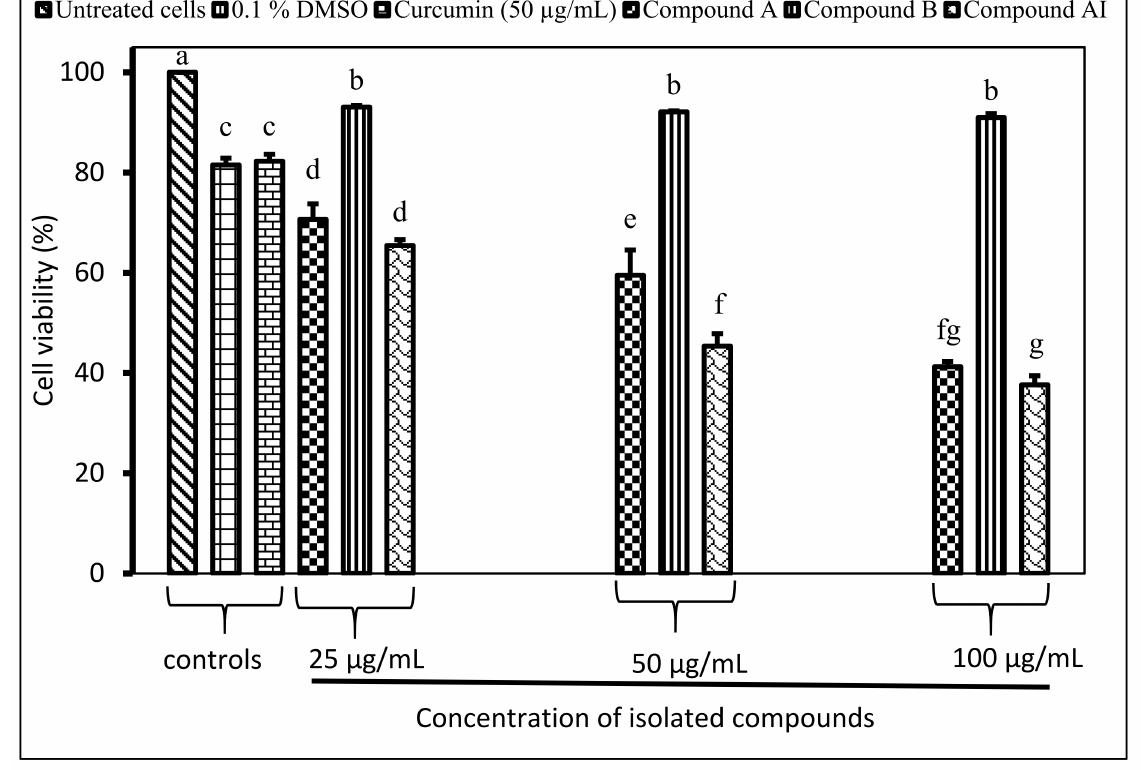
Figure 2. In vitro cytotoxicity of isolated compounds against the proliferation of Raw 264.7 macrophage cells. Compound A and compound B were isolated from the Combretum erythrophyllum leaf acetone extract. Compound AI was isolated from the Withania somnifera leaf ethyl acetate extract. A cell viability assay was determined using the MTT (3-(4,5-Dimethylthiazol-2- yl)-2,5-diphenyltetrazolium bromide) assay. Untreated cells, 0.1% DMSO and curcumin were included as controls. There were three replicates for each treatment group. Data were treated statistically, and bars bearing the different letters indicate significant differences between mean values ( p = 0.05), as determined by Duncan’s Multiple Range